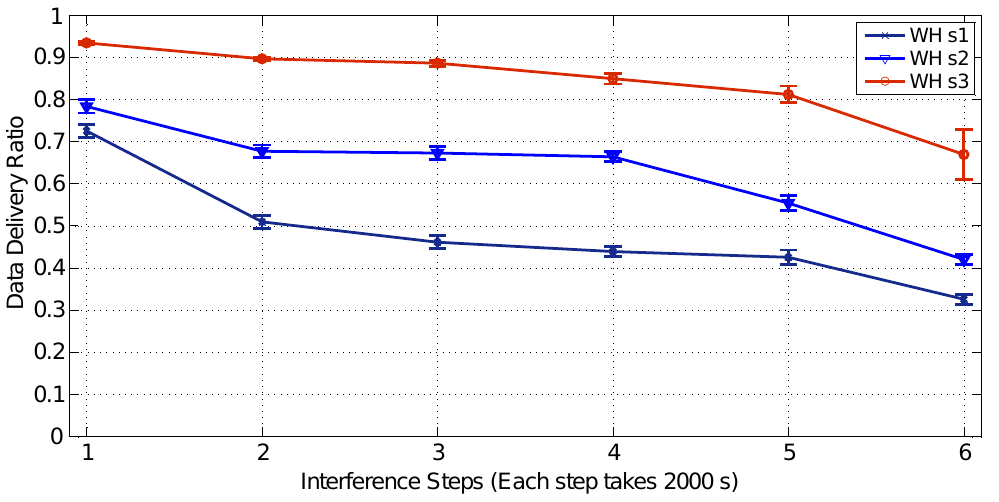
Figure 25. Data delivery ratio differences in three scenarios.